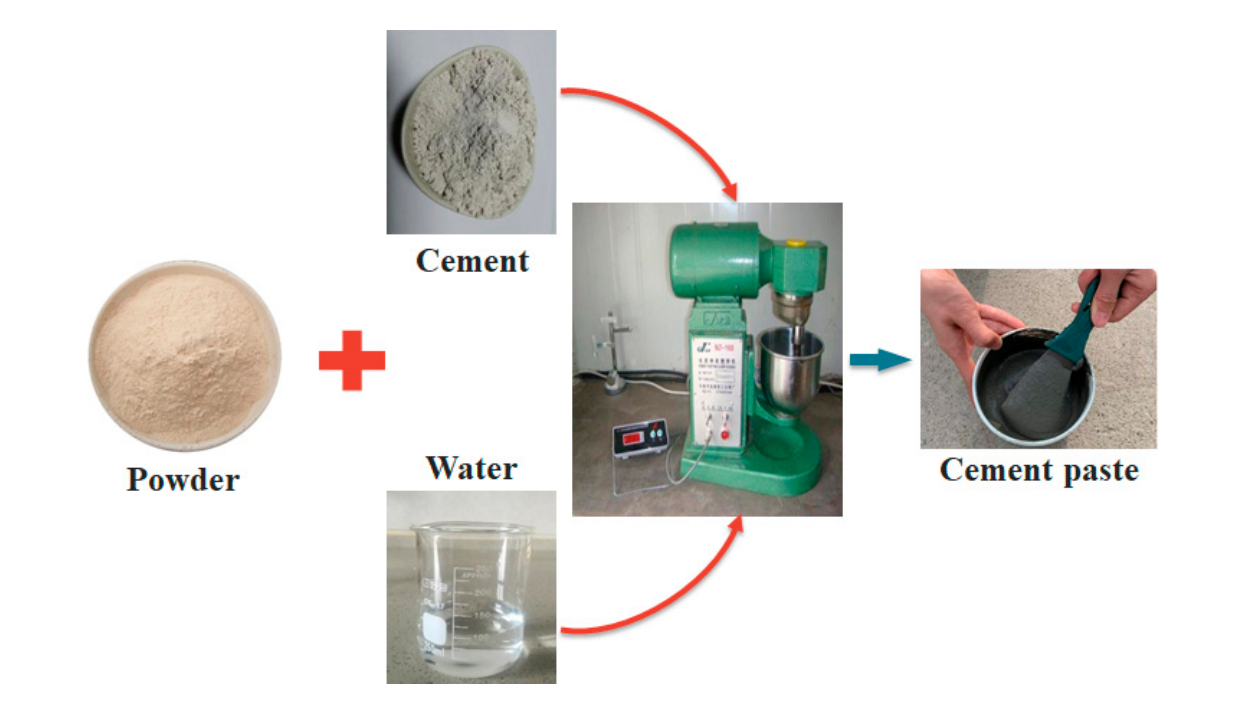
Figure 4. Production of cement paste. Table 3. Mix proportion of cement pastes.